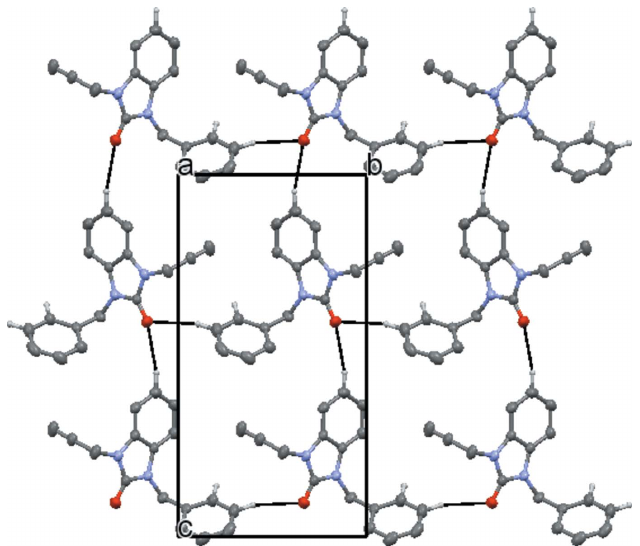
Figure 2 Plan view of a portion of one layer seen along the a -axis direction. Intermolecular C—H Bnzdzl (cid:3)(cid:3)(cid:3) O and C—H Bnzy (cid:3)(cid:3)(cid:3) O (Bnzdzl = benzo- diazole and Bnzy = benzyl) hydrogen bonds are shown by dashed lines.